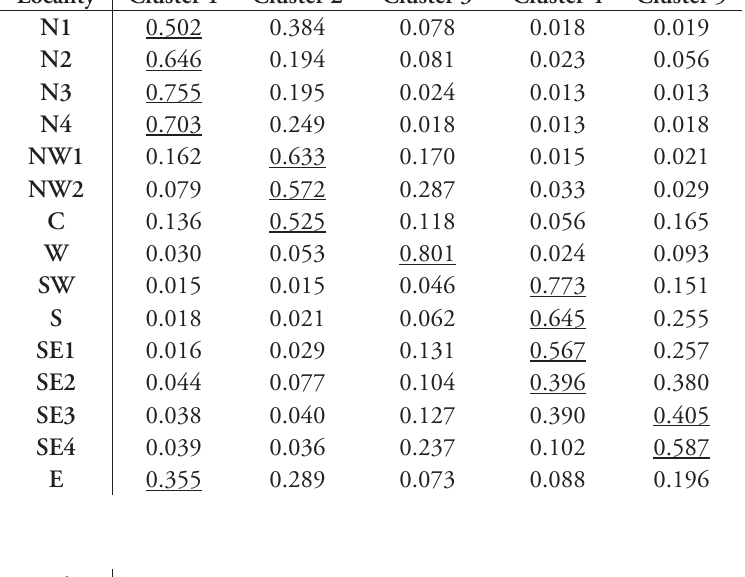
Table S2. Sample